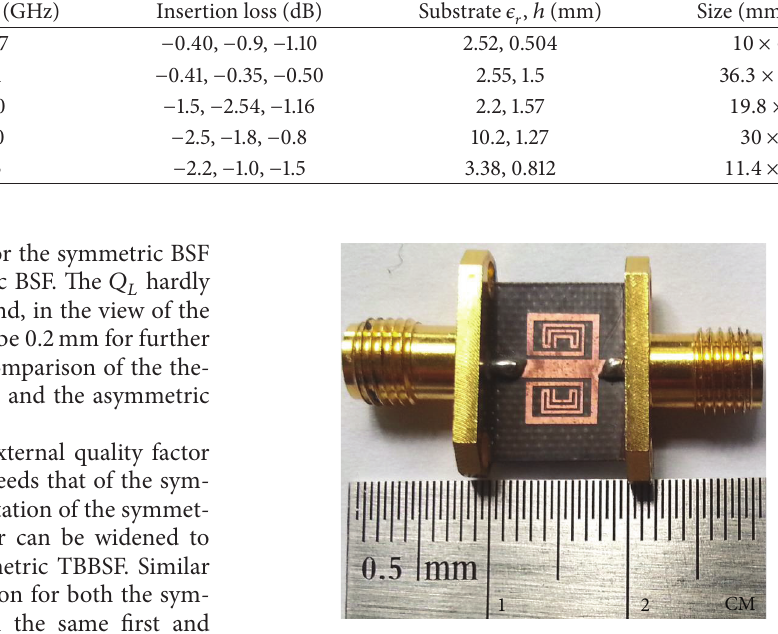
Figure 8: Photograph of the proposed